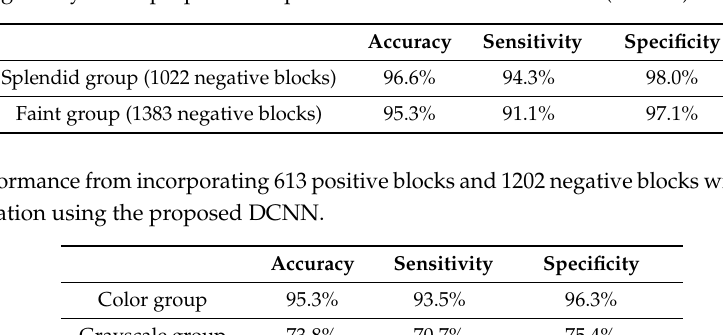
Table 2. Performance from incorporating 613 positive blocks and two negative groups, showing the di ff erentiating ability of the proposed deep convolutional neural network (DCNN).